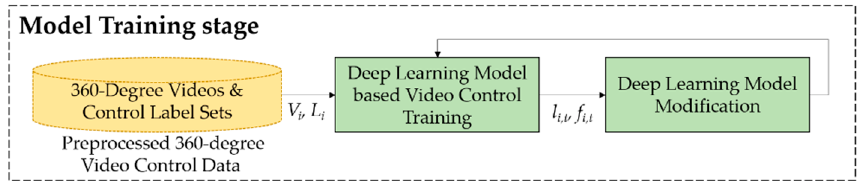
Figure 4. Process of training the deep learning model based on end-to-end control.